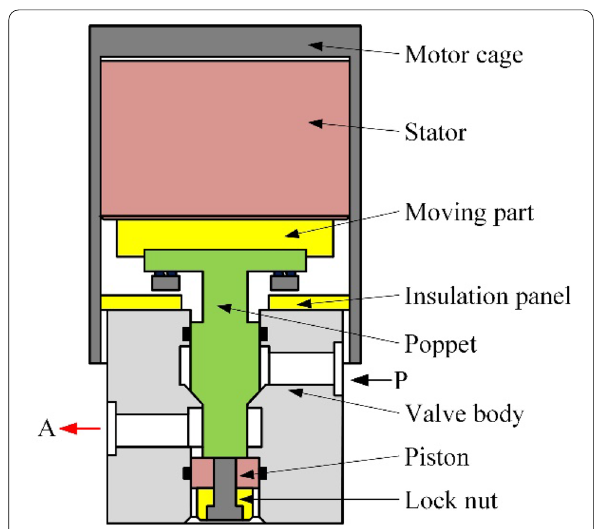
Figure 8 Voice coil motor driven valve designed by Liu et